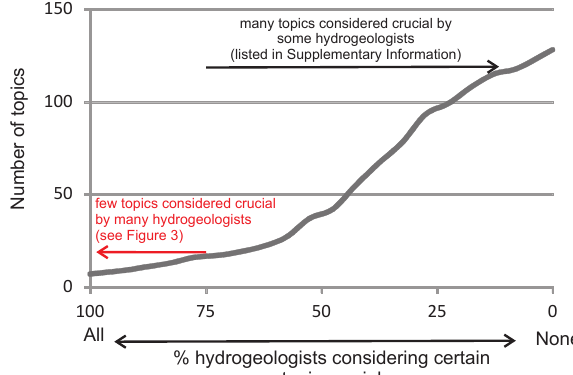
Fig. 2. Cumulative distribution of responses of hydrogeology in- structors ( n = 68) asked what topics should be included in an under- graduate hydrogeology course. The voluntary survey is described in the Introduction. The 15 topics that > 75% of hydrogeologists con- sider crucial are list in Fig. 3. The > 100 other topics that some hydrogeologists consider crucial are listed in Fig. S1 in the Supple-